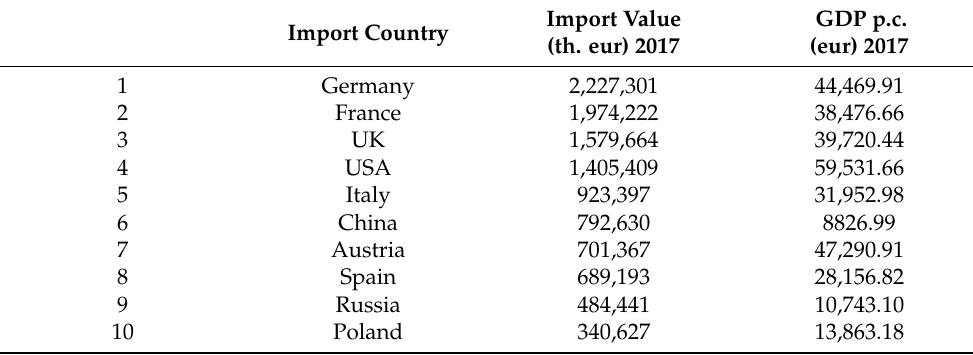
Table 3. The most important export markets for Slovakia in HS 8703.